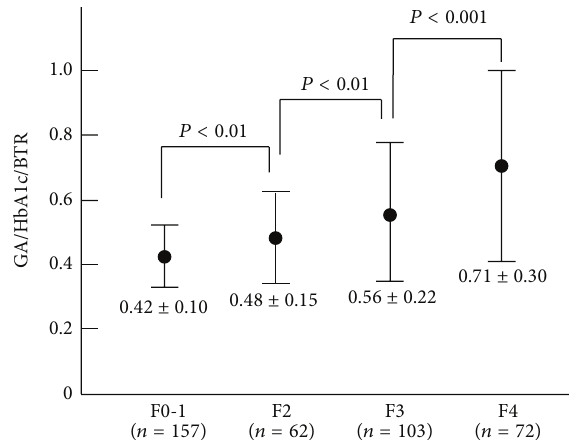
Figure 1: Values of the metabolic-related new index (GA/HbA1c/ BTR) in HCV-positive patients. The GA/HbA1c/BTR value increase correlated with the stage of liver fibrosis. There were significant differences in all of the comparisons between the fibrotic stages, including F0-F1 versus F2, F2 versus F3, and F3 versus F4 groups.